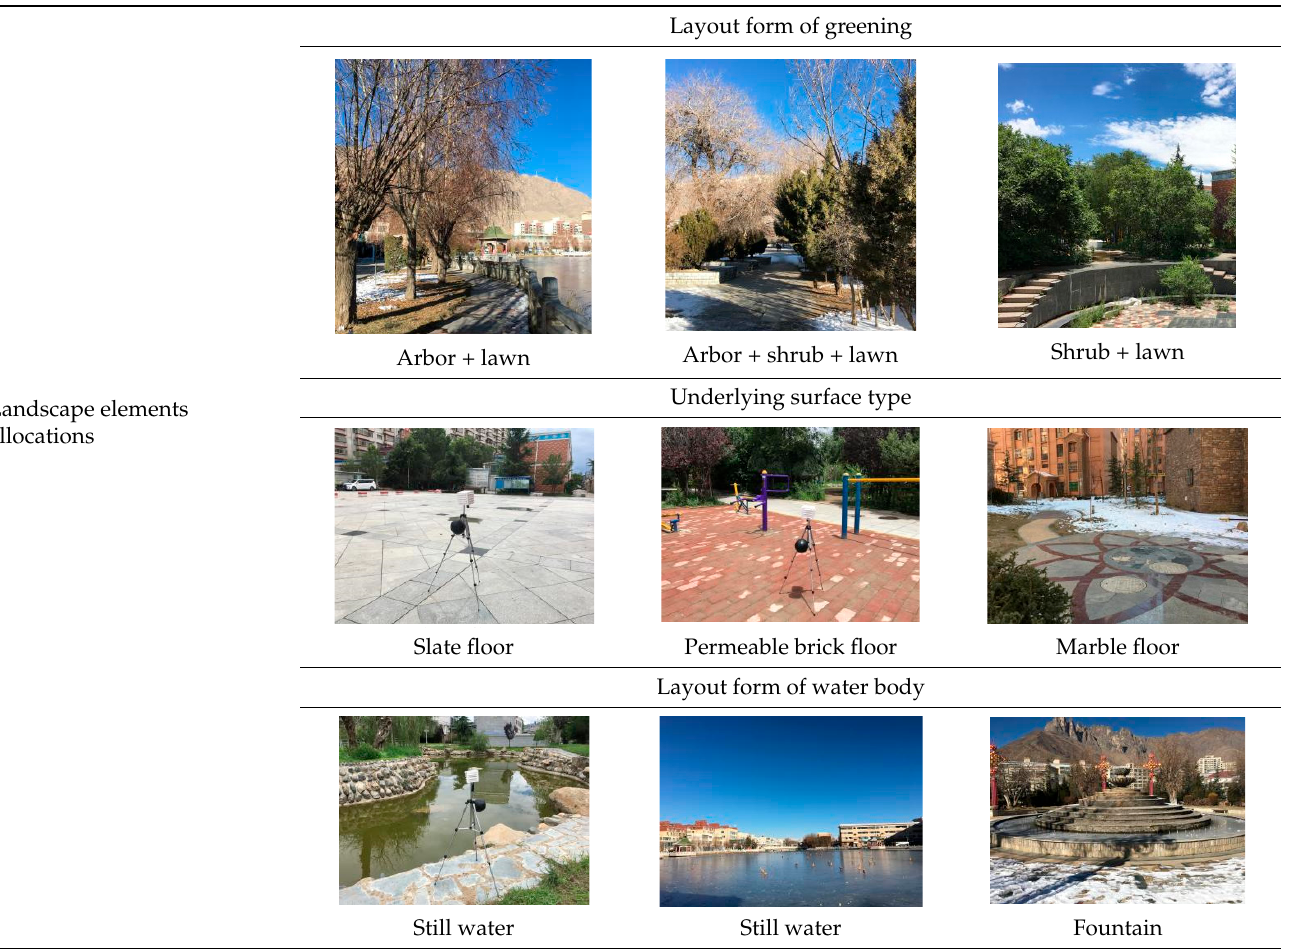
Table 2. Landscape elements allocations characteristics of residential areas in Lhasa.